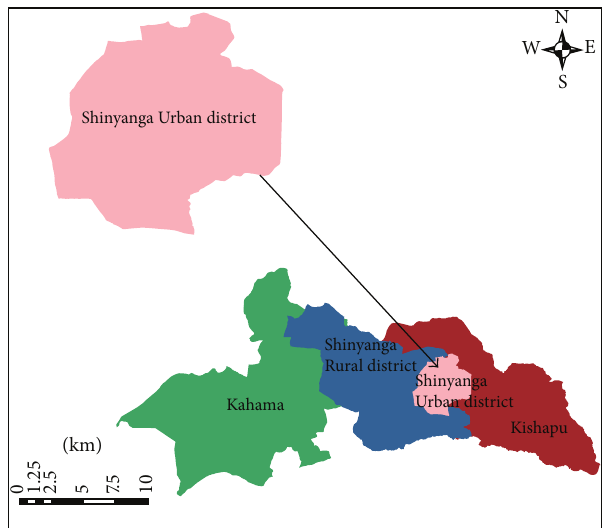
Figure 1: Map of Shinyanga Region showing location of the study